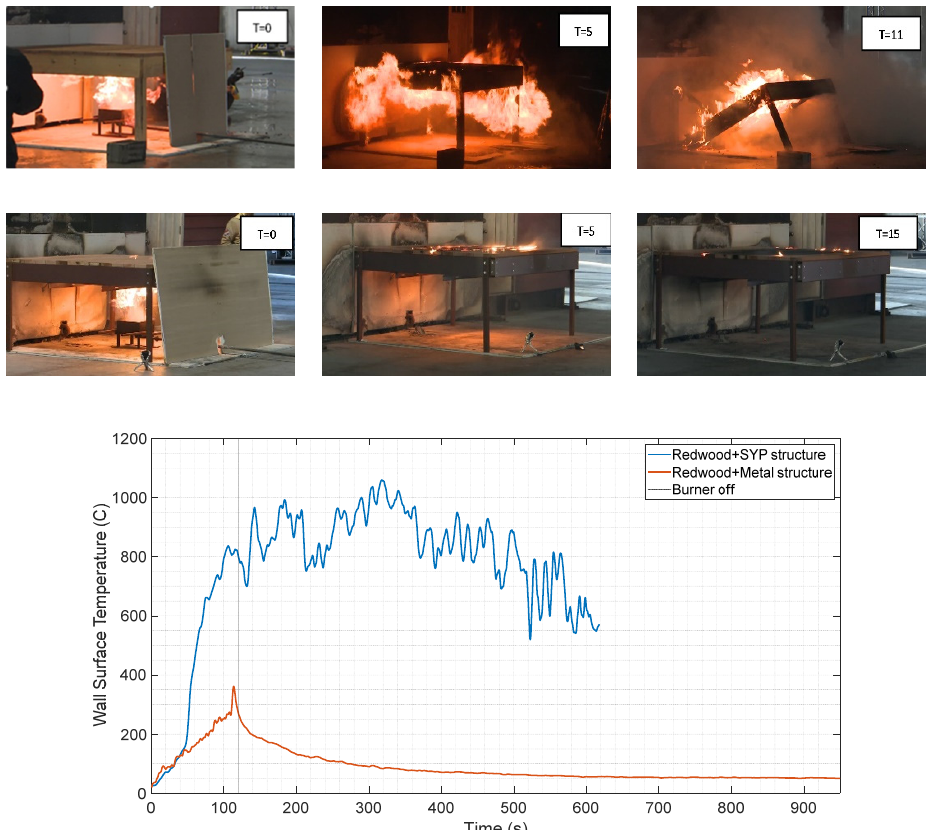
Figure 17. Time-lapse of redwood deck boards with ( First Row ) Southern Yellow Pine joists and ( Second Row ) metal supporting system, and the wall temperature.